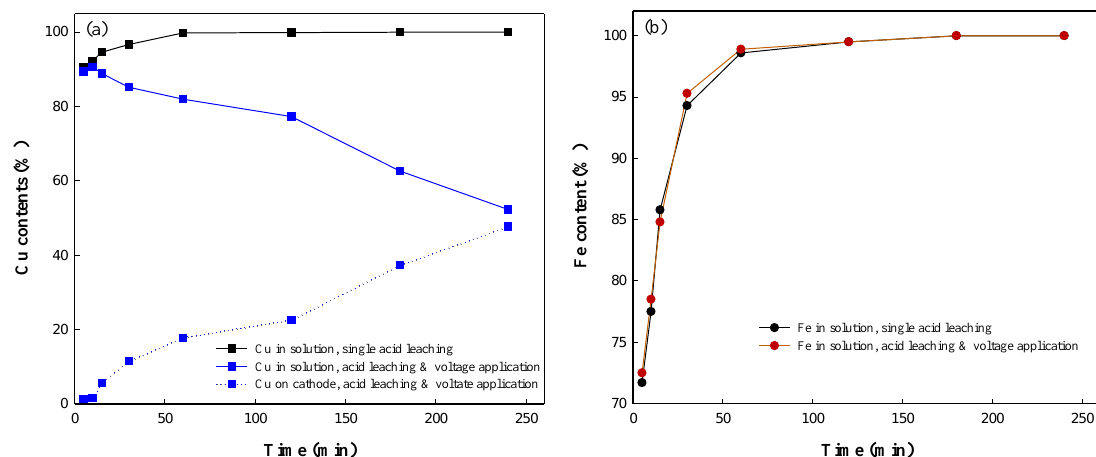
Figure 2. The variation of metal contents in the solution. ( a ) Copper (Cu), ( b ) Iron (Fe). Single acid leaching conditions: 200 mL H 2 SO 4 100 g/L, 4 h, 25 °C. Electrodeposition conditions: 200 mL H 2 SO 4 100 g/L, current density 10 mA/cm 2 , 4 h, 25 °C.